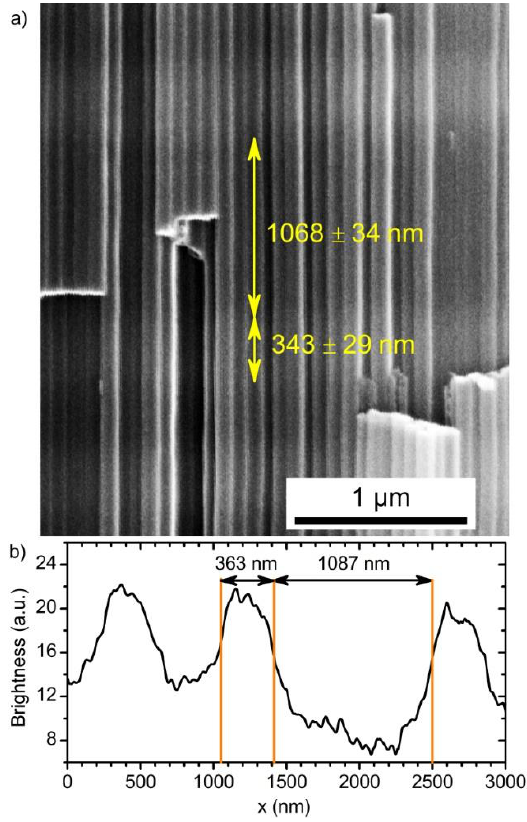
Figure 4. Morphology of porous anodic titanium oxide PC. ( a ) SEM image of a cleavage of the sample PC_3 with one thick layer obtained at 60 V. ( b ) An example of brightness profile of randomly selected nanotube from the panel in ( a ).